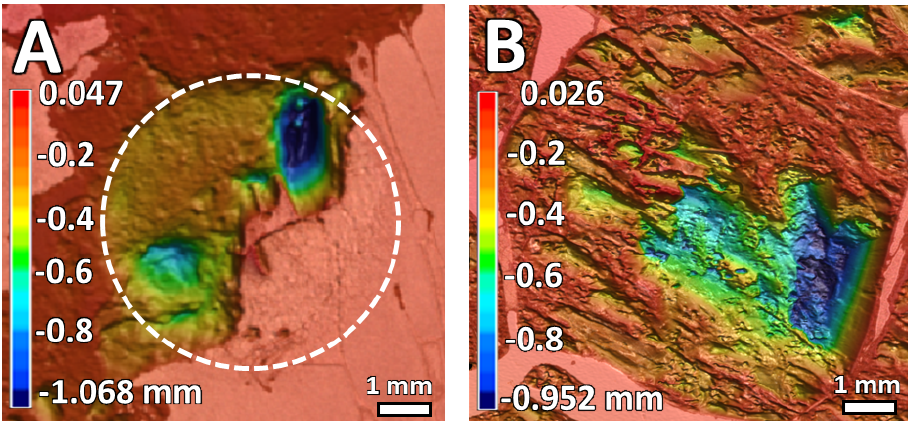
Figure 12. PALS ablation crater morphology, indicating different resistances of metal and chondritic material of the Seymchan pallasite ( panel A , dashed white circle). Panel B introduces an example of the olivine mineral chipped in the Seymchan pallasite by the PALS